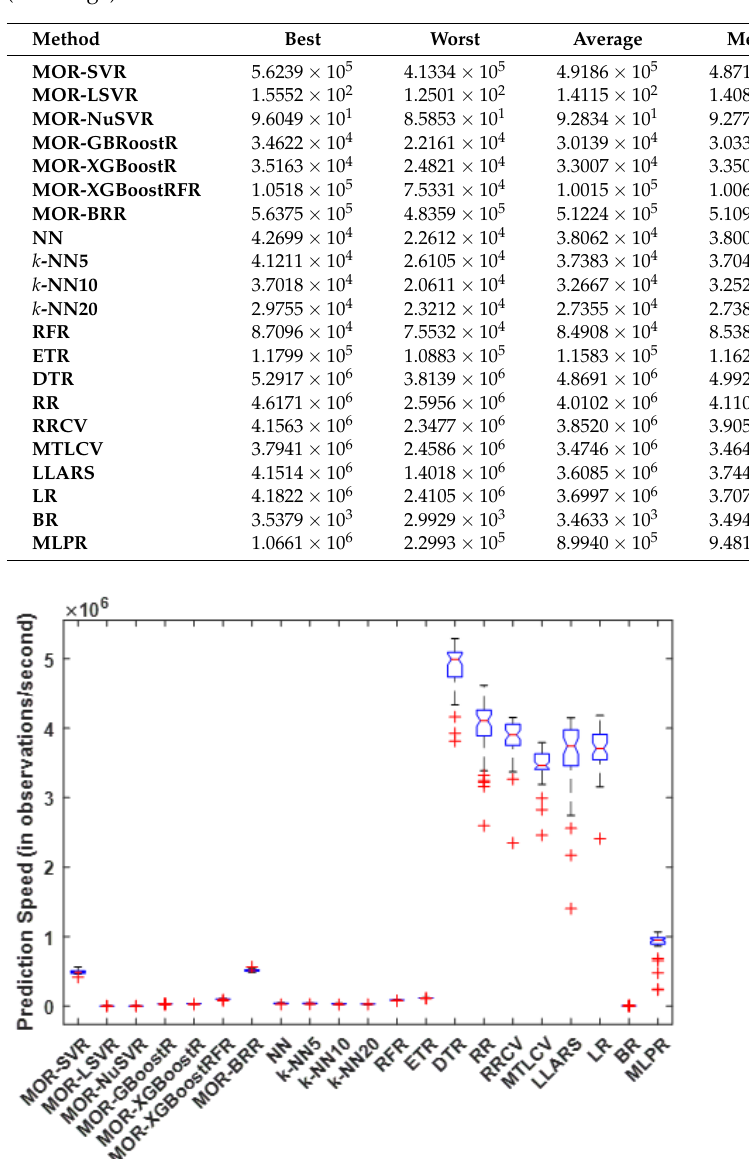
Figure 5. Box plots of PS (over 50 statistical runs) for all methods for the first